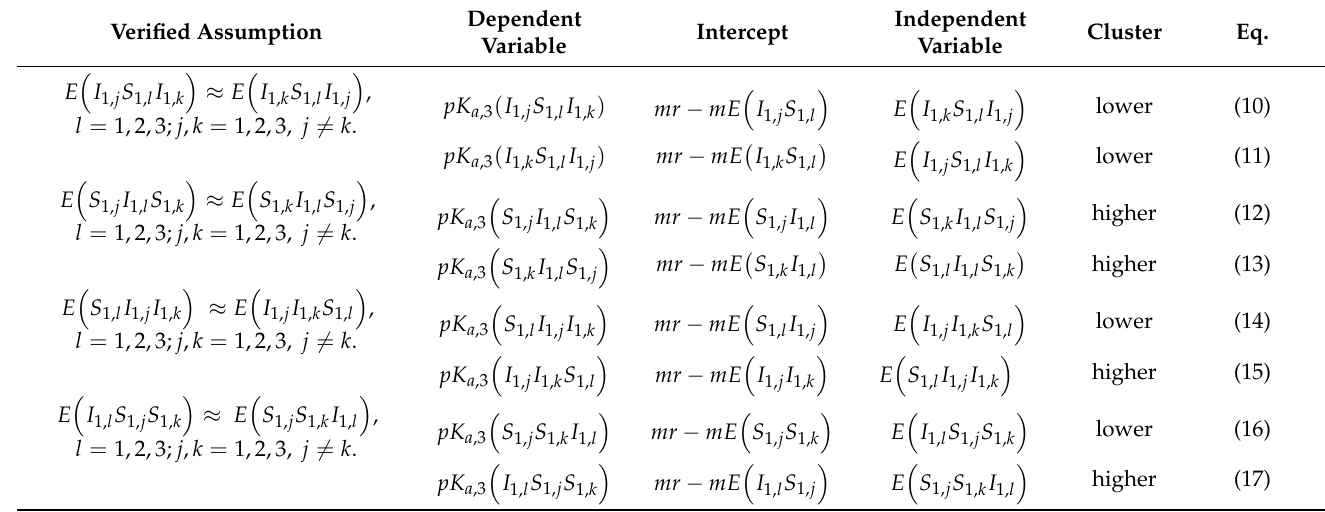
Table 3. Equations for prediction of all deprotonation routes based on the parallel linear